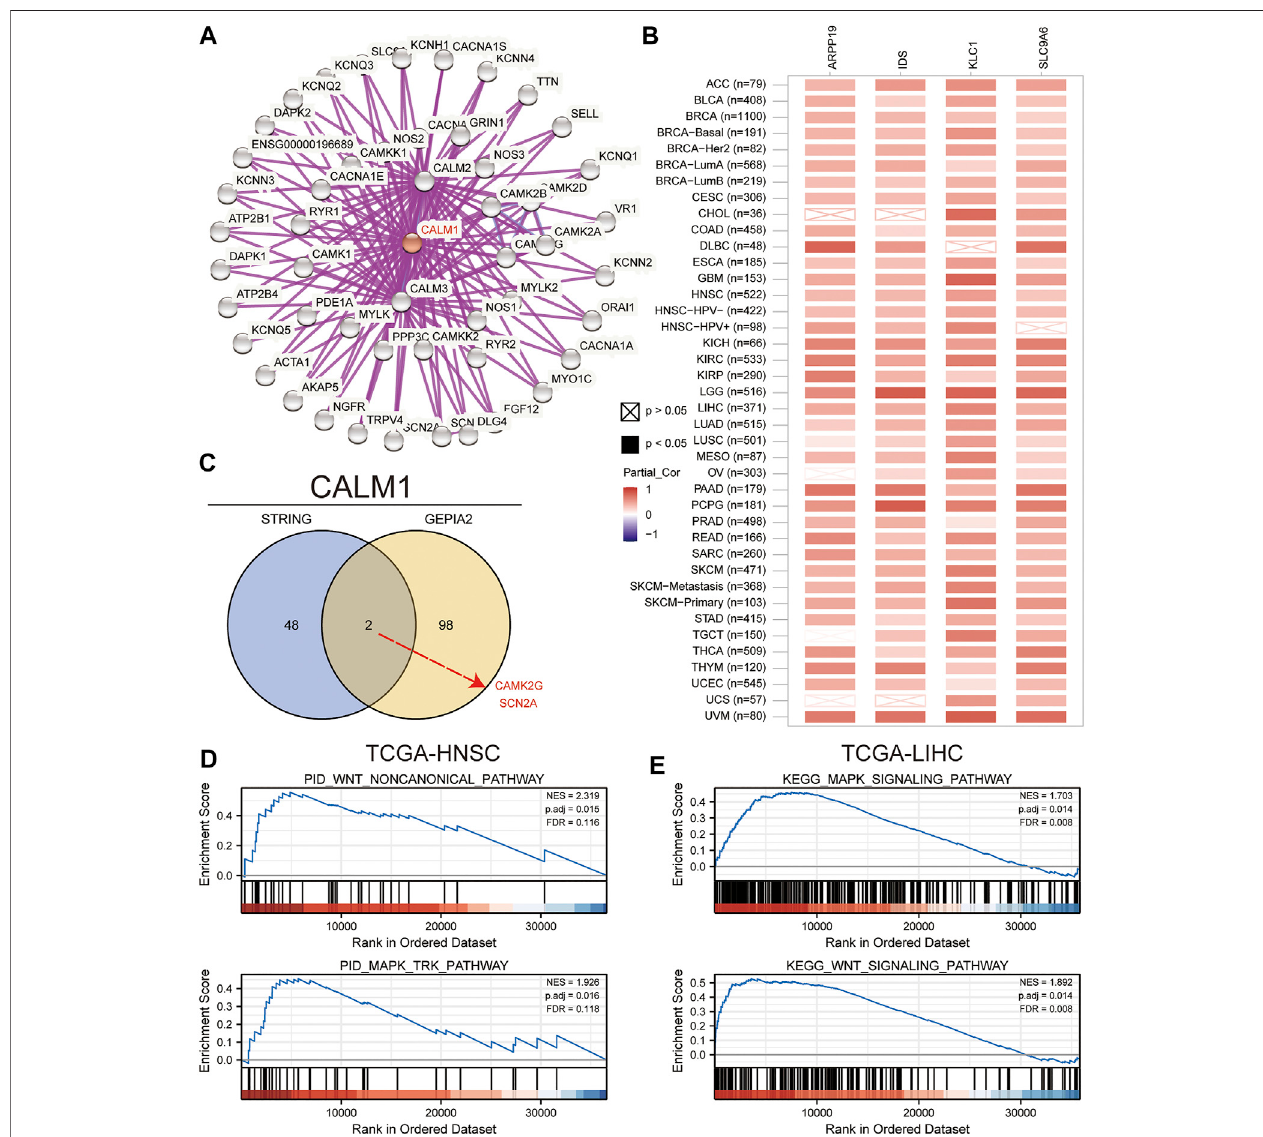
FIGURE7| Insightsinto CALM1 function. (A) Weobtainedtheprotein-proteininteractionnetworkof CALM1 usingtheSTRINGwebsite. (B) Weanalyzed thepan- cancer correlation between CALM1 expression and SLC9A6 , ARPP19 , KLC1 , and IDS using the TIMER2 website. (C) We conducted an intersection analysis for the CALM1 -binding and CALM1 -correlated genes. Finally, we performed GSEA to elucidate functional differences for CALM1 -high expression group versus CALM1 -low expression group in HNSC (D) and LIHC (E) . SLC9A6 , solute carrier family 9-member a6; ARPP19 , CAMP regulated phosphoprotein; KLC1 , kinesin light chain 1; IDS ,iduronate2-sulfatase; CAMK2G ,calcium/calmodulindependentproteinkinaseIIgamma; SCN2A ,sodiumvoltage-gatedchannelalphasubunit2;GSEA,GeneSet Enrichment Analysis; TCGA, The Cancer Genome Atlas; HNSC, head and neck squamous cell carcinoma; LIHC, liver hepatocellular carcinoma.